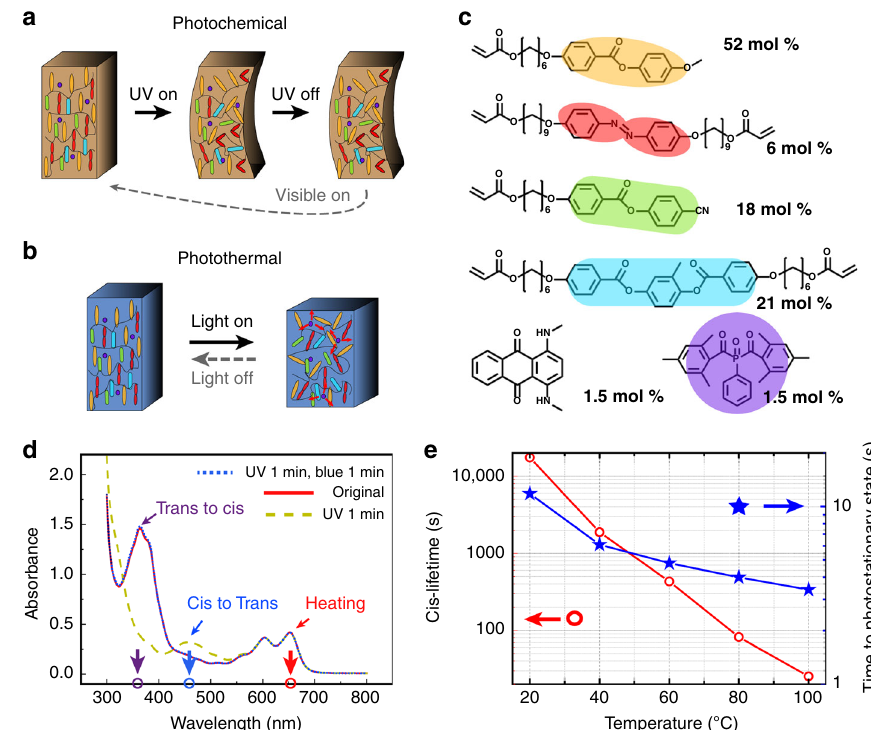
Fig. 2 Design of a synergistic photoactuator. Schematic drawing of a photochemical and b photothermal actuation. c Chemical composition of the liquid crystal monomer mixture. d , UV – Vis spectra of LCN fi lm containing both DB14 and azobenzene crosslinks. The arrows indicate the excitation wavelengths used in the actuation: 365 nm for trans – cis isomerization (purple arrow), 460 nm for cis – trans isomerization (blue arrow), and 660 nm for photothermal heating (red arrow). e Cis -lifetime during the thermal relaxation in the dark ( cis – trans ) and time to reach photostationary state upon UV irradiation ( trans – cis ) at different